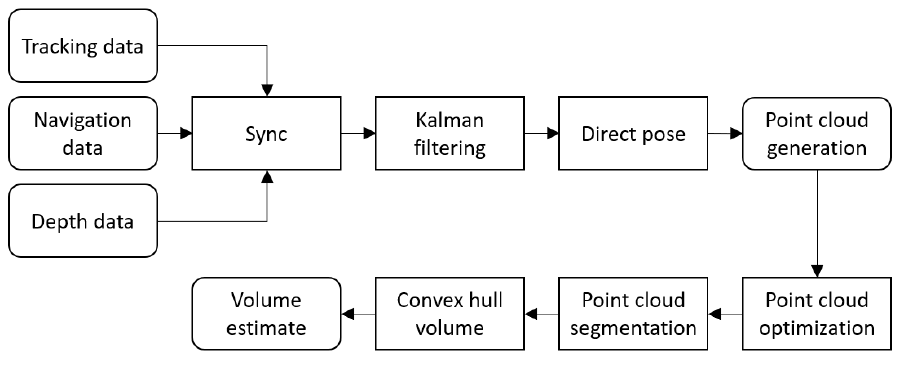
Figure 3. Proposed workflow.